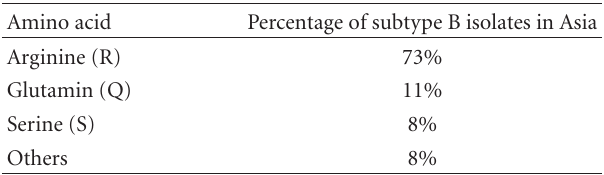
Table 1: Amino acids frequency at the fourth position of the GPGX tetramer of V3 loop of HIV-1 subtype B.